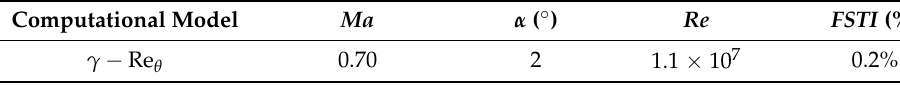
Table 1. Boundary conditions of grid independence verification.